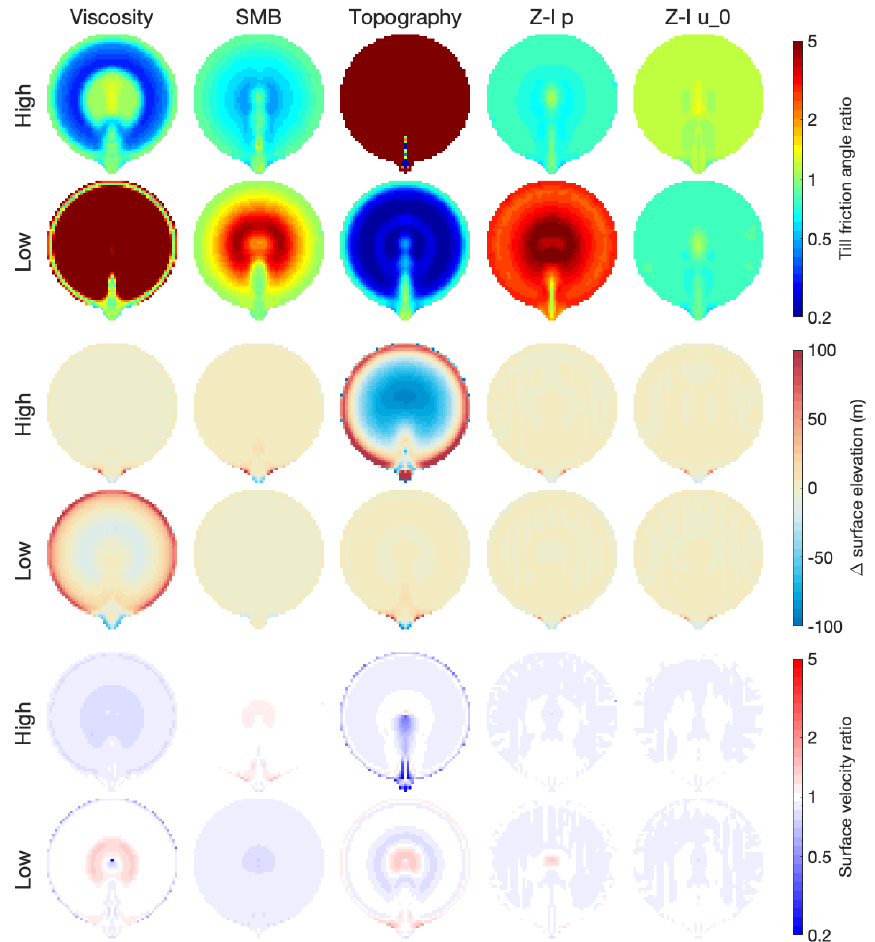
Figure 6. Errors in inverted bed roughness, surface elevation, and surface velocity (relative to the target) for the perturbed inversions of experiment I. The top two rows show the errors in the bed roughness for the high and low perturbed inversions; the middle two rows show the errors in the steady-state surface elevation; and the bottom two rows show the errors in the surface velocity. Each column represents a single perturbed model parameter: viscosity (i.e. Glen’s flow law factor A ), surface mass balance, subglacial topography, and the exponent p and transition velocity u 0 in the Zoet–Iverson sliding